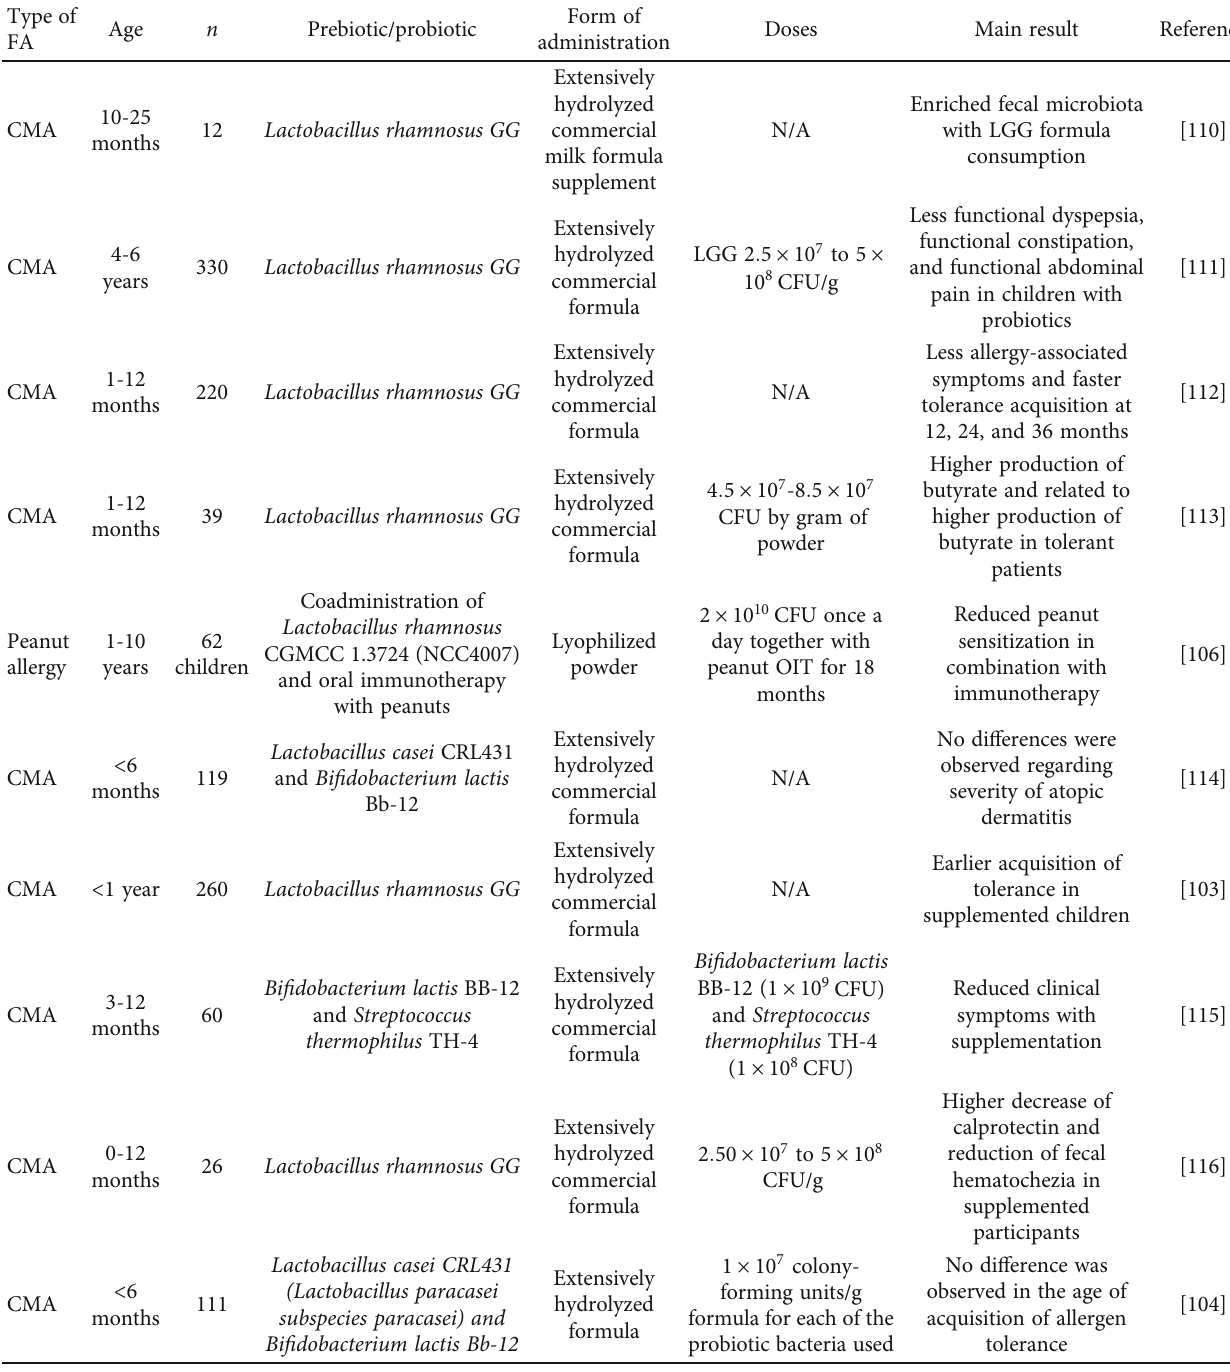
Table 1: Evidence regarding microbiota interventions in children with